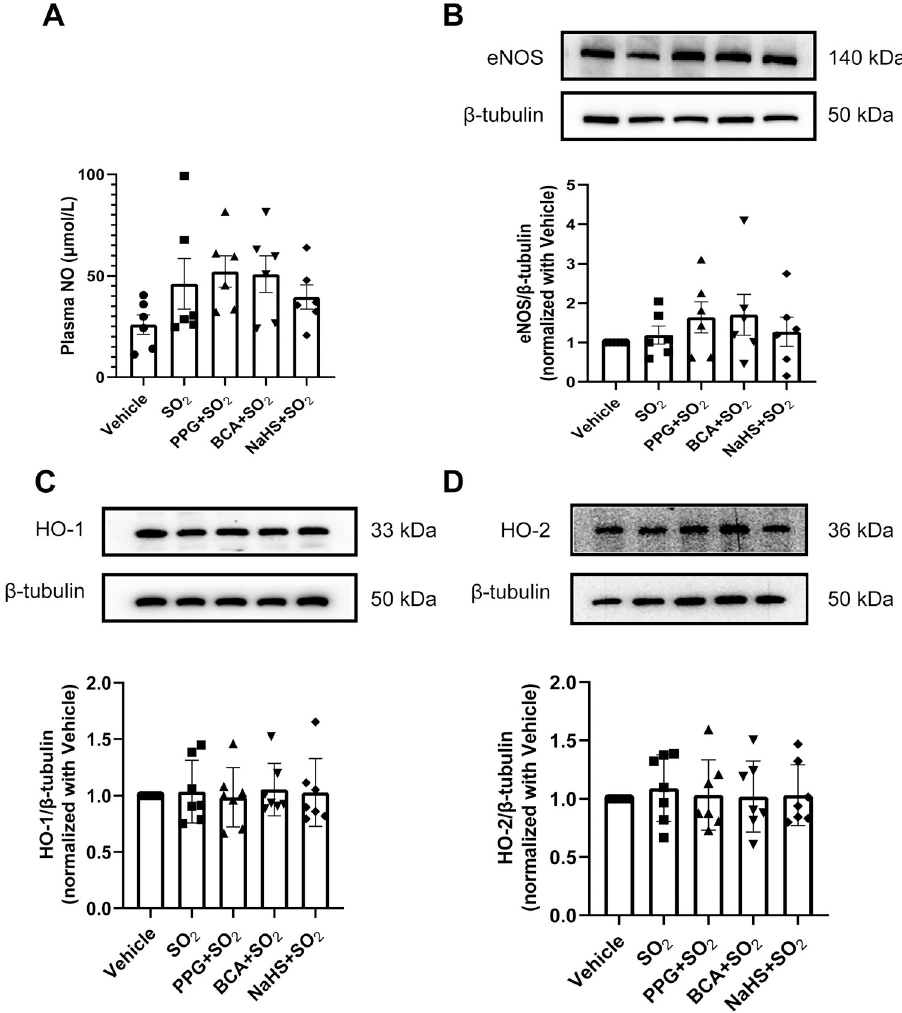
Fig 5. NO/eNOS and CO/HO pathway did not change during the regulation of H 2 S on SO 2 . Rats were intravenously injected with PPG (30 mg/kg), BCA (50 mg/kg), NaHS (56 μ mol/kg) or equal volume of physiological saline. After 30 minutes, the rats were given an intravenous injection of Na 2 SO 3 /NaHSO 3 (40 μ mol/kg). Blood samples and aortic tissues were collected after 1.5 minutes. (A) Plasma NO content in each group. (B-D) Representative western blots and quantitative analysis of eNOS (B), HO-1 (C) and HO-2 (D) in the aortic tissues of each group. Data are presented as mean ± SEM; n = 6–7 in each group; One-way ANOVA followed by LSD post hoc test.